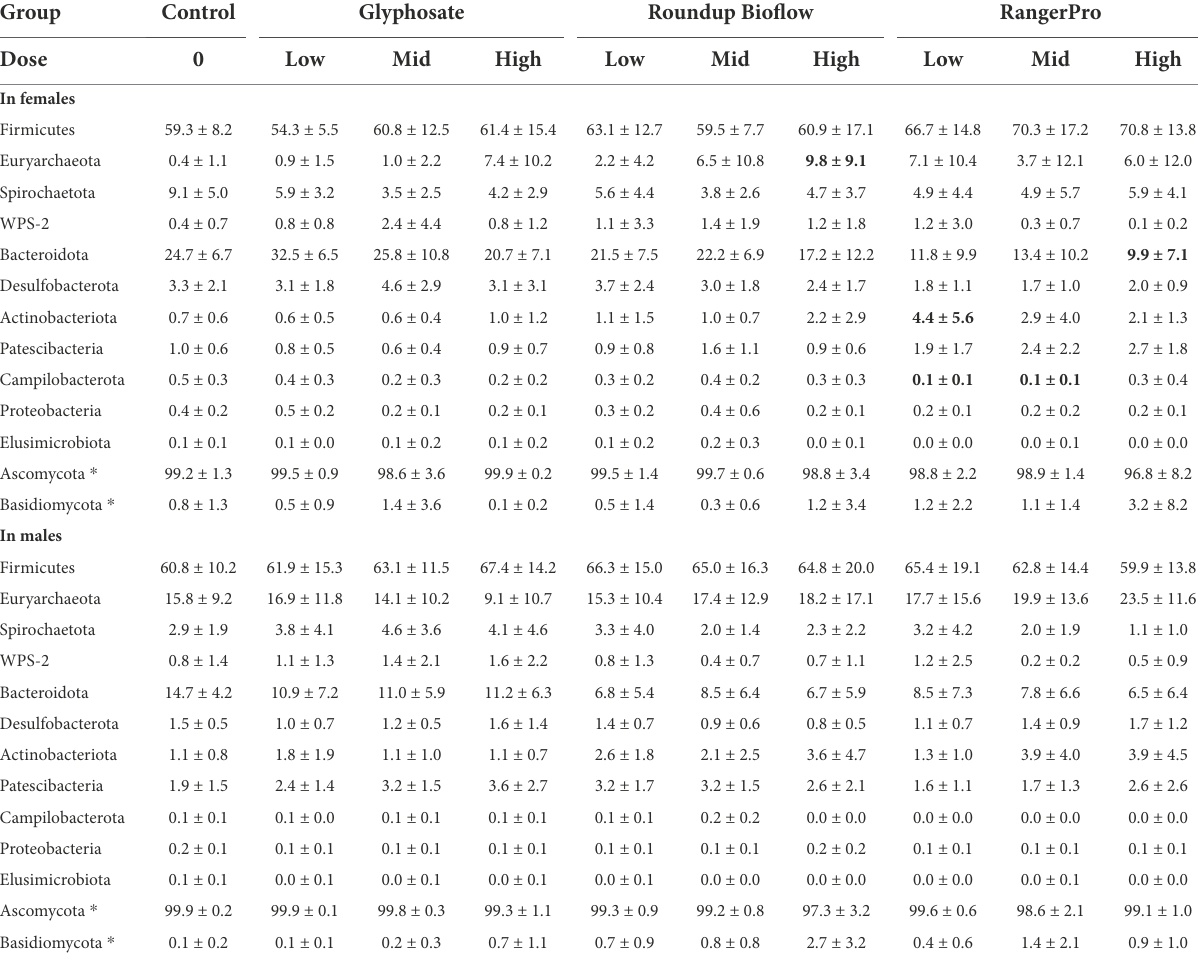
TABLE 1 Changes in phyla abundance in the caecum microbiota of male and female rats exposed to glyphosate and the glyphosate formulated products Roundup Biolow and RangerPro.